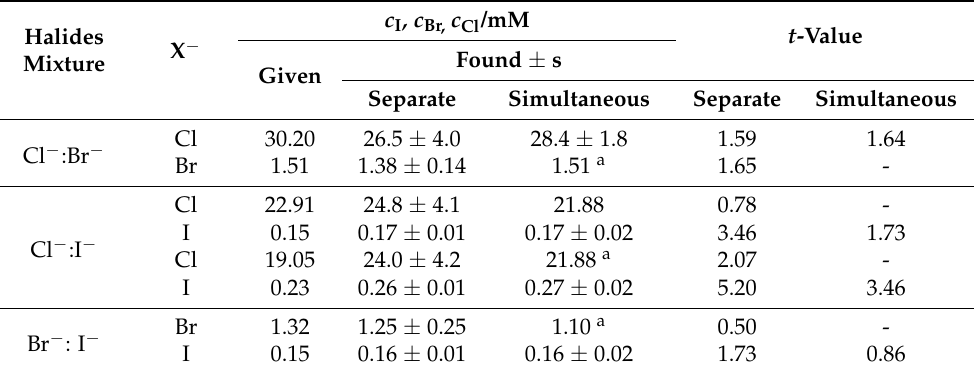
Table 5. The results of analysis of halide mixture by ANN analysis of experimental data obtained from a digital scanner (see details in Figure